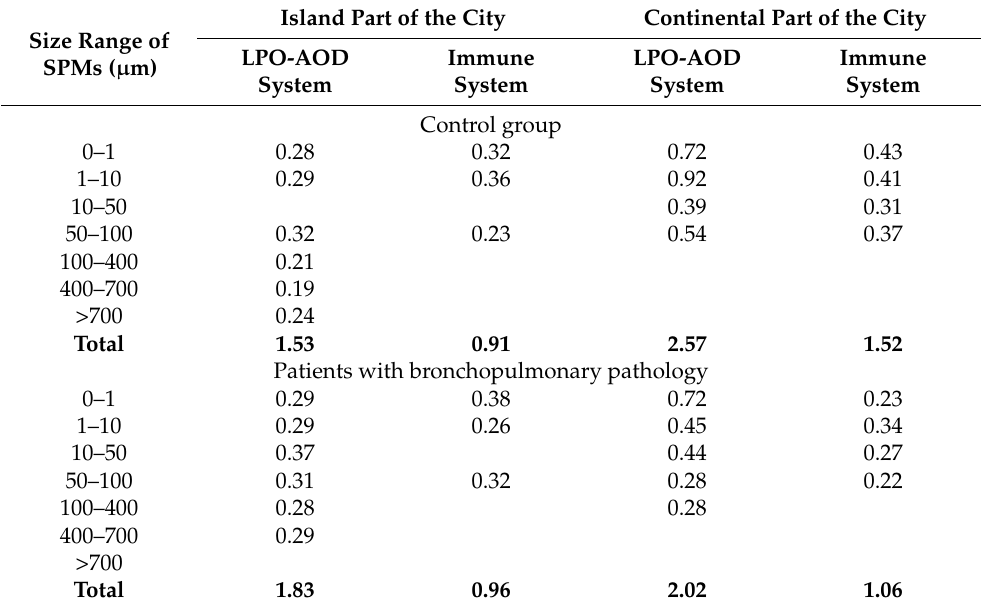
Table 2. Effect (D%, p < 0.05) of atmospheric surface layer SPMs of different size ranges on the blood immune and metabolic parameters in healthy subjects and patients with bronchopulmonary pathology living under different environmental